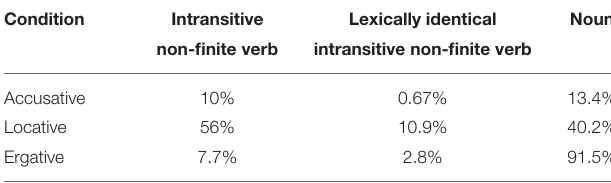
TABLE 5 | Percentage completions of intransitive non-finite verbs and nouns in Accusative, Locative, and Ergative conditions for Experiment 2.